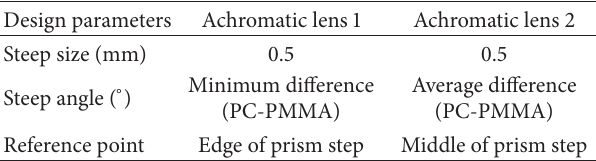
Table 1: Achromatic lenses and distinguishing parameters. Design parameters